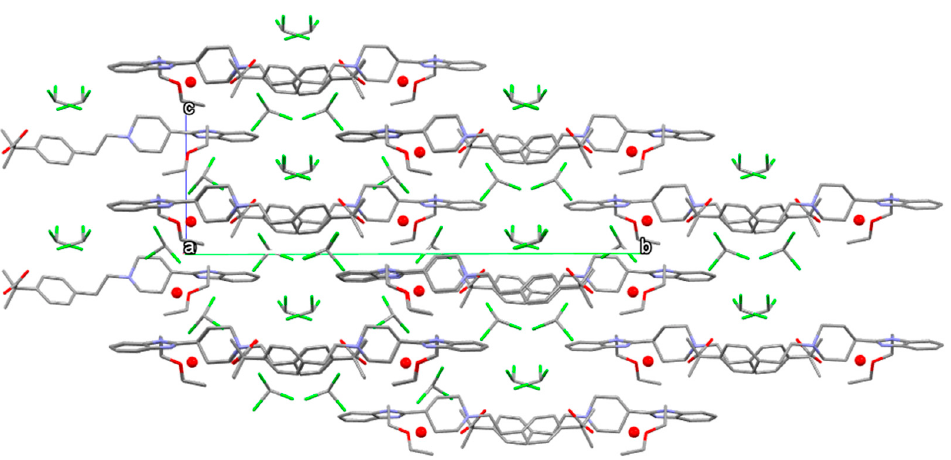
Figure 18. Packing diagram of form S 3CHCl3-H2O viewed parallel to [100]. Water molecules repre- sented by red balls. Hydrogens have been omitted for clarity.